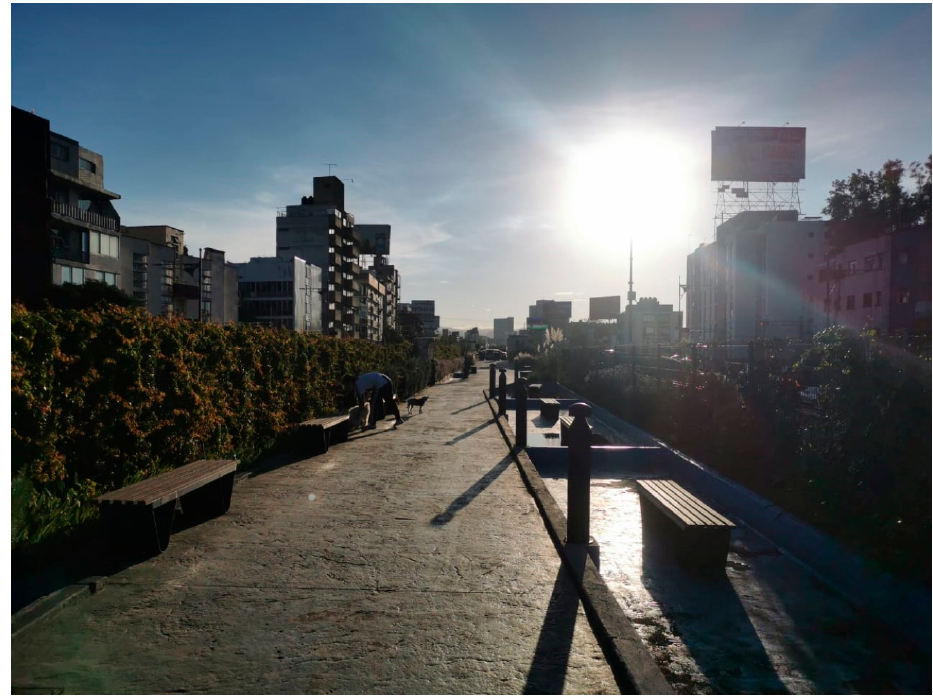
Figure 3. Park near Participant 8’s house. The park’s occupancy rate is monitored by police. Often, open areas with the physical capacity for social distancing were eventually used as COVID ‐ 19 testing sites. This became an additional limitation on the use of these spaces. For example, despite having access to what he described as a medium ‐ sized park, Participant 11 revealed that he felt uneasy using this green space. The municipal govern ‐ ment had installed a testing center there, forcing him to avoid the UGS except to pass through it (see Figure 4). The other green area near Participant 11 is located inside his apartment complex. Since the space is relatively small, opportunities to exercise there are limited. Nonetheless, he mentioned that looking at the greenery through his window pos ‐ itively affected his mood despite the size of the space.